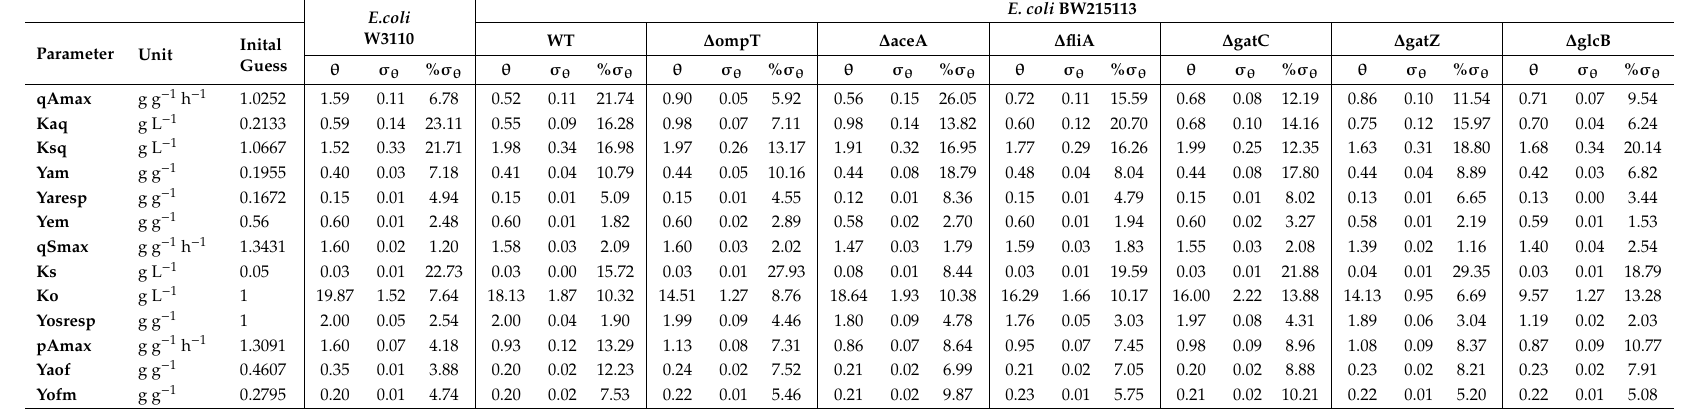
Table 3. Values, variance and relative variance of the adjusted parameters for all clones after the final model calibration